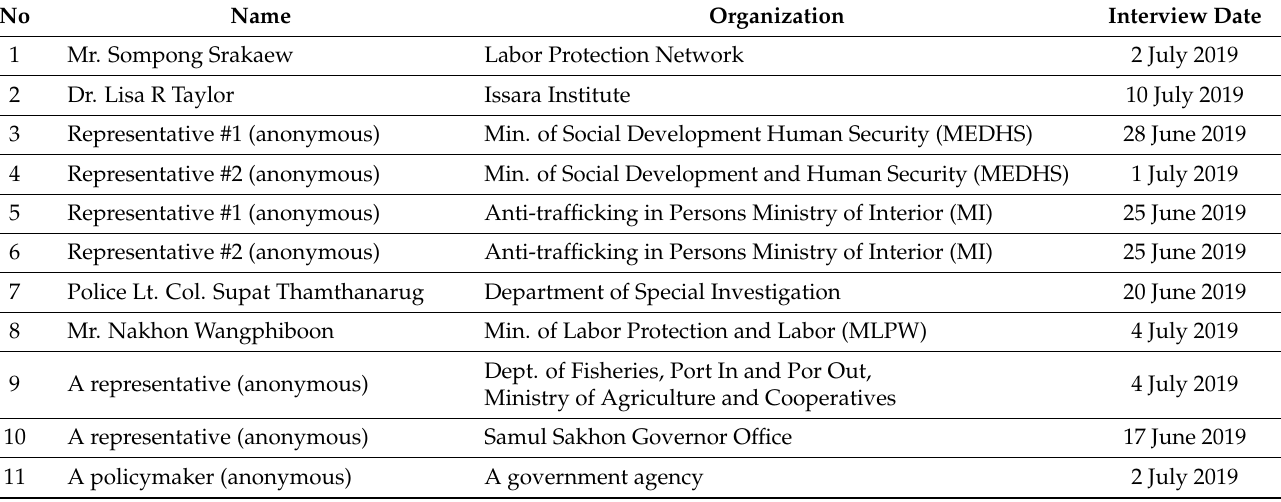
Table 1. List of